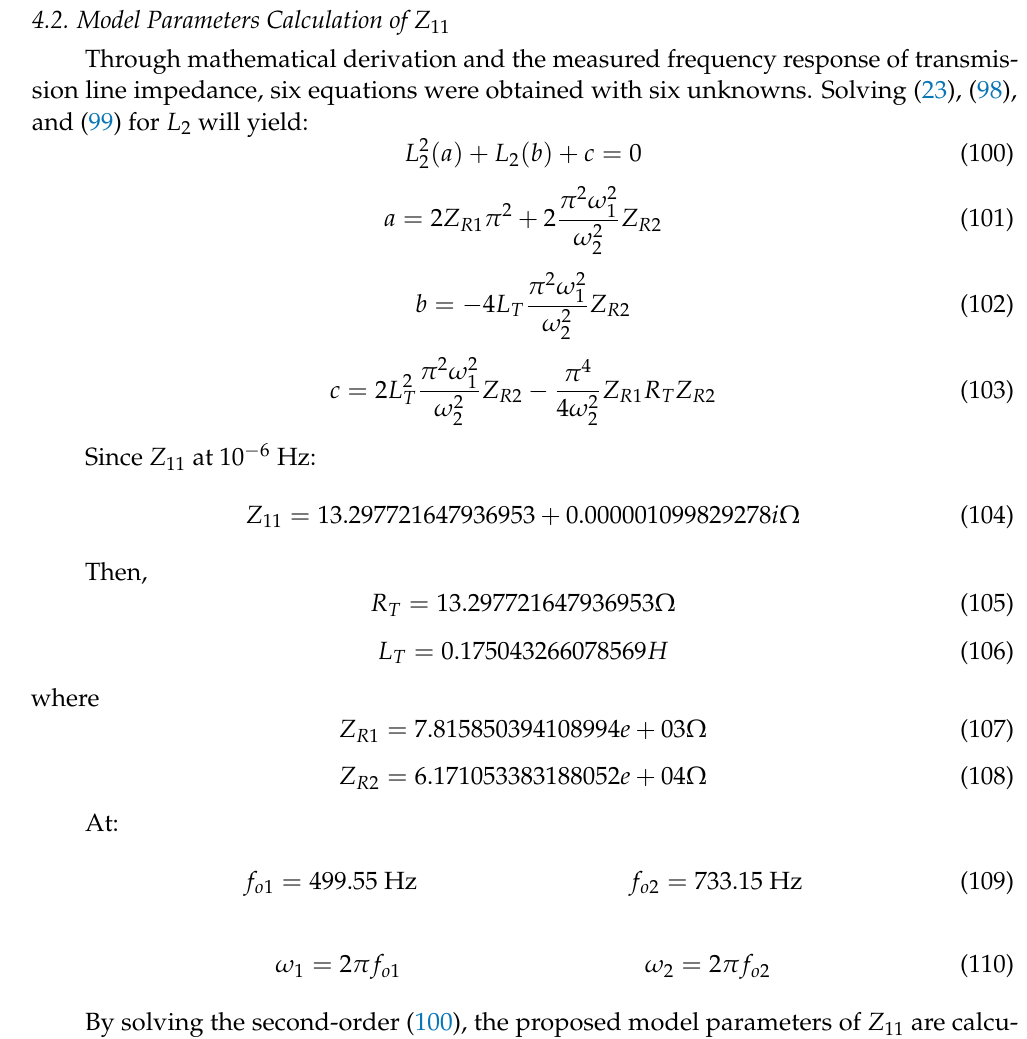
Figure 8. Frequency response measurements of transmission line real